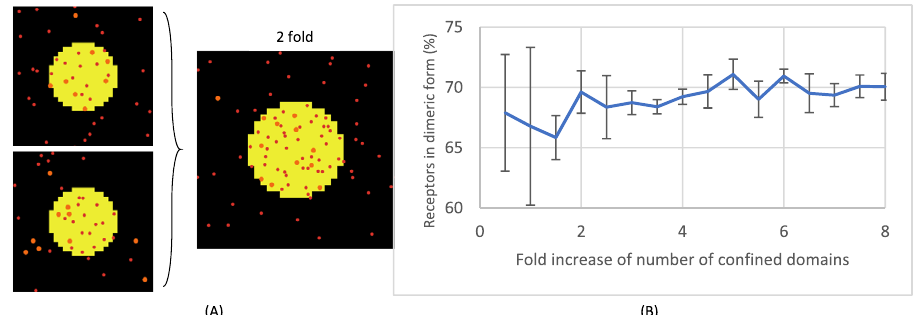
Figure 6. Merging of confined domains has no effect on receptor dimerisation. Simulated was the effect of merging two confined domains while fixing the total occupied area size. ( A ) Snapshots of two confined domains merged into one (yellow circles). The red and orange dots represent monomeric and dimeric receptors, respectively. ( B ) Simulation for determining dimeric receptors as a function of the fold merging of confined domains. Simulations were repeated three times, mean ± SD; Pearson correlation of 0.40 indicates a weak positive correlation between confined domain folds and dimerisation.